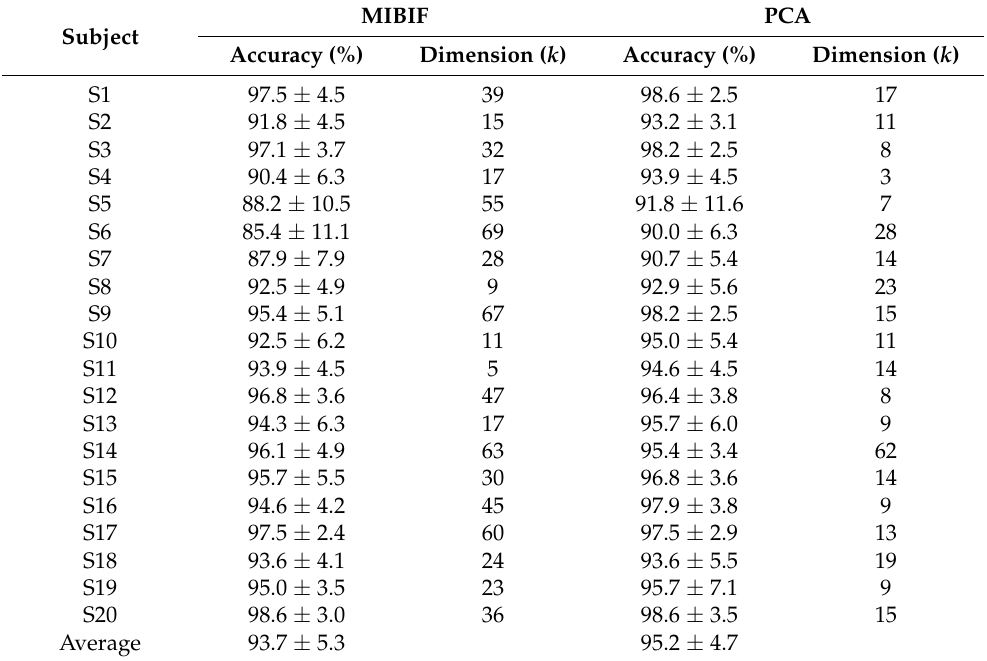
Table 10. The highest classification accuracies and the selected feature dimension ( k ) by MIBIF and PCA for all subjects on the experimental data we